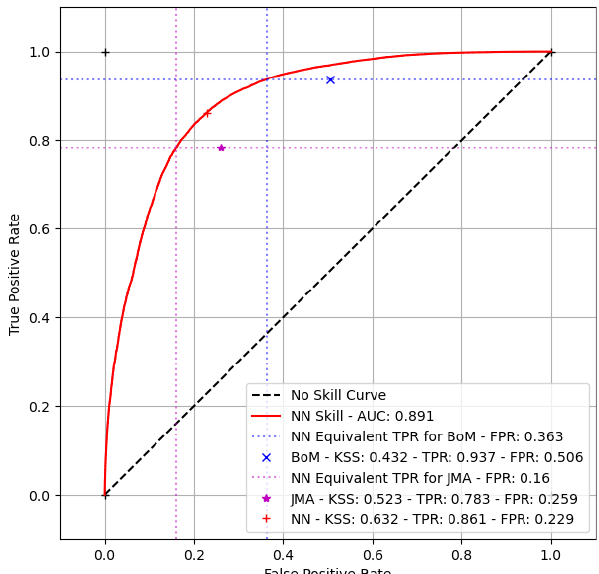
Figure 5. ROC curve comparing the false positive and true posi- tive rate of the cloud masks. The ROC curve is produced using the continuous output from the neural network, whilst each point is cal- culated using the binary cloud mask for each algorithm. The dotted lines indicate where the algorithm point would be if it used a bi- nary threshold that matched the associated algorithms’ (denoted by colour)